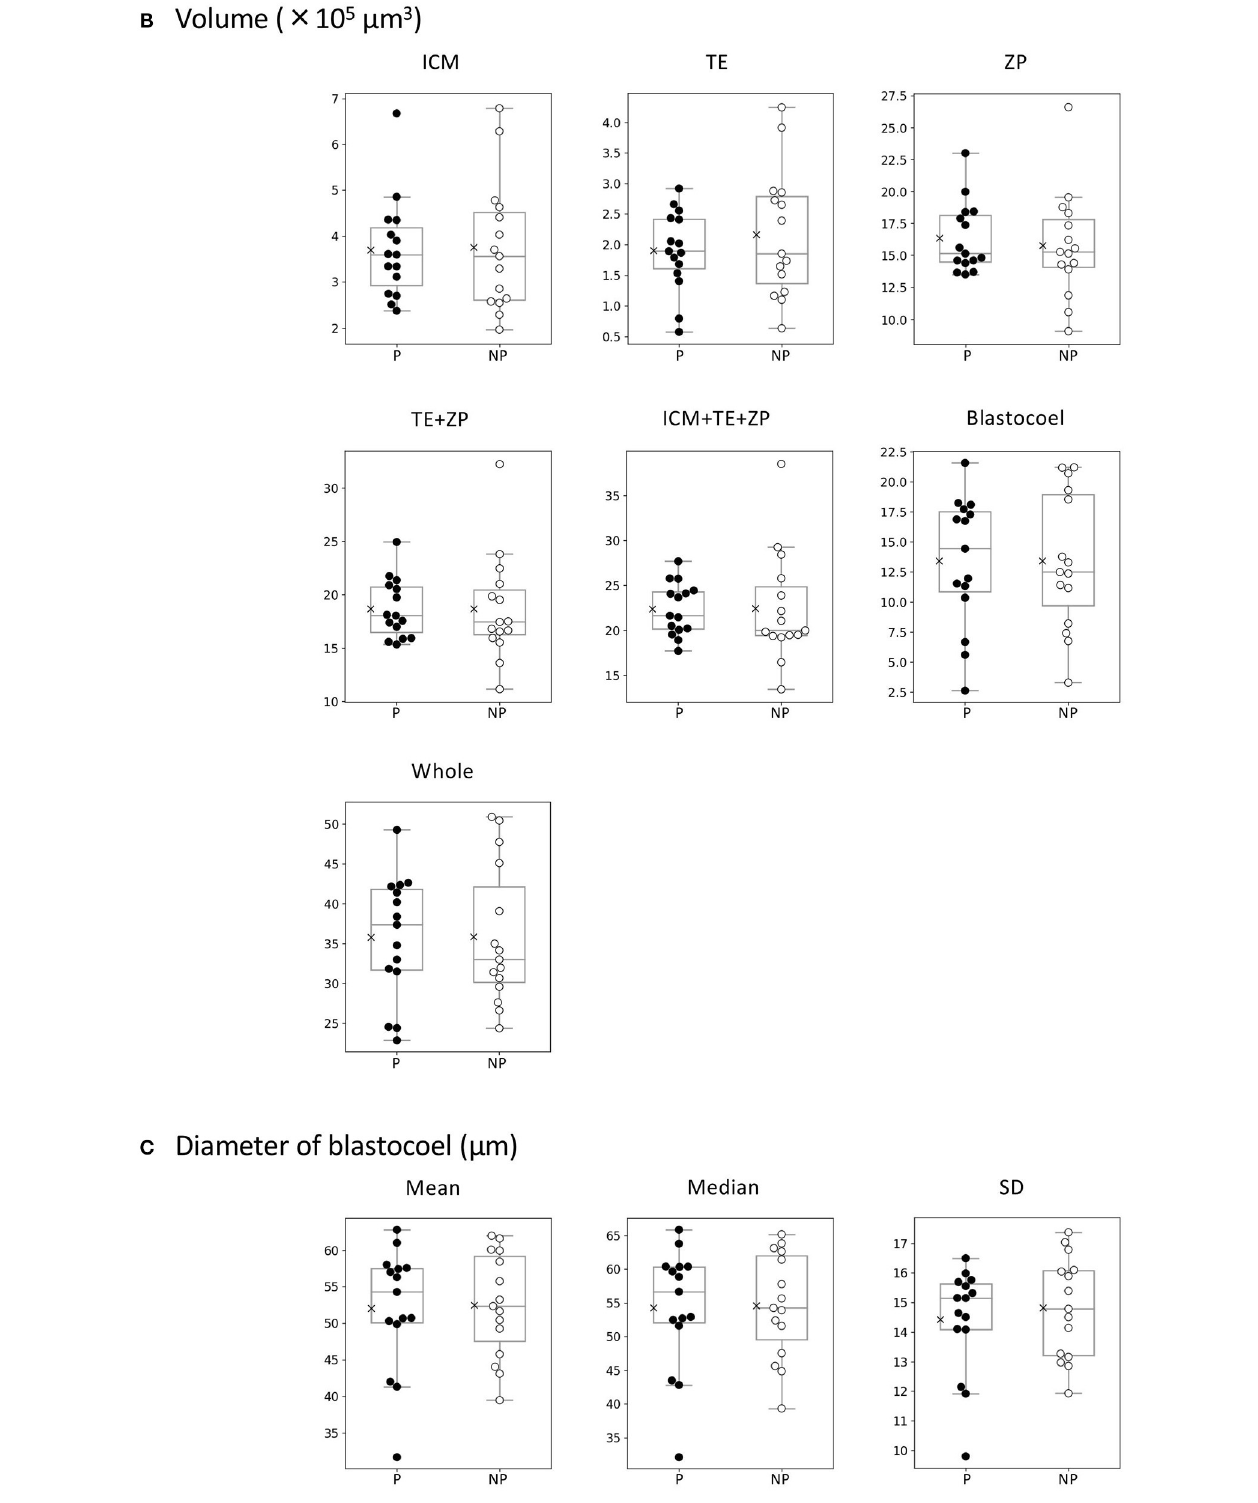
FIGURE 8 | Comparison of 22 morphological parameters of bovine blastocysts between pregnancy (P: n = 15) and non-pregnancy (NP: n = 15). (A) Parameters related to structural thickness including mean, median, and standard deviation (SD) of inner cell mass (ICM), trophectoderm (TE), zona pellucida (ZP), and TE +